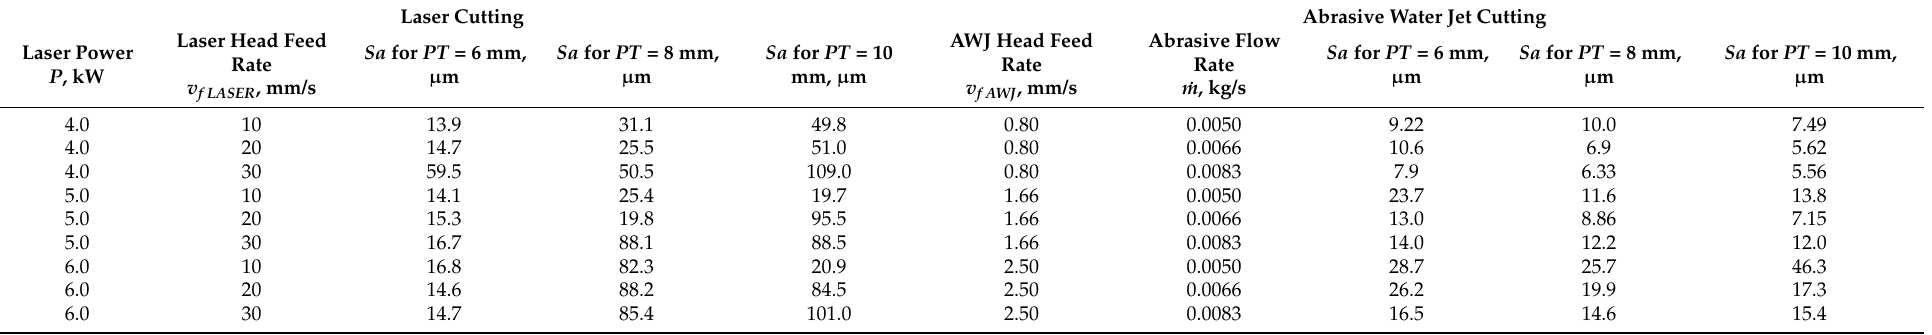
Table 2. Values of the Sa parameter of the surface after cutting for plate with thickness PT = 6, 8 and 10 mm and for variable power P and cutting head feed rate v f LASER in laser cutting